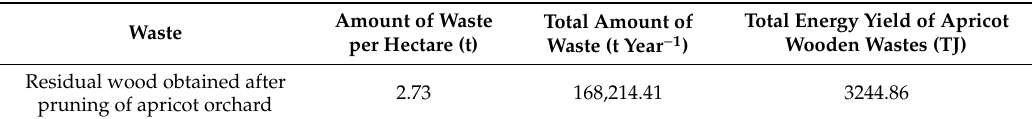
Table 5. Yearly amount of wastes and total energy yield obtained after pruning of apricot orchards in